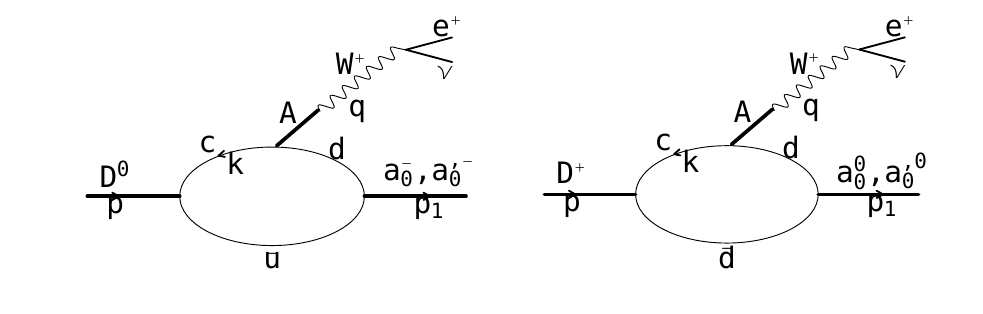
, a (cid:48)− ) e + ν and D + → ( a 0 0 0